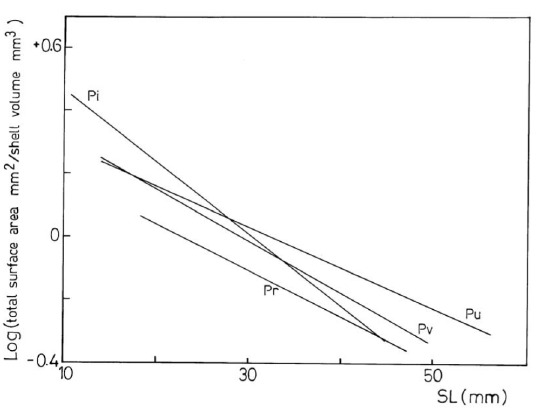
Fig. 8. Plots of the ratio between total surface area and shell vol- ume, against shell length (Pi = P. intermedia , Pr = P. rustica , Pu = P. ulyssiponensis , Pv = P. vulgata ).